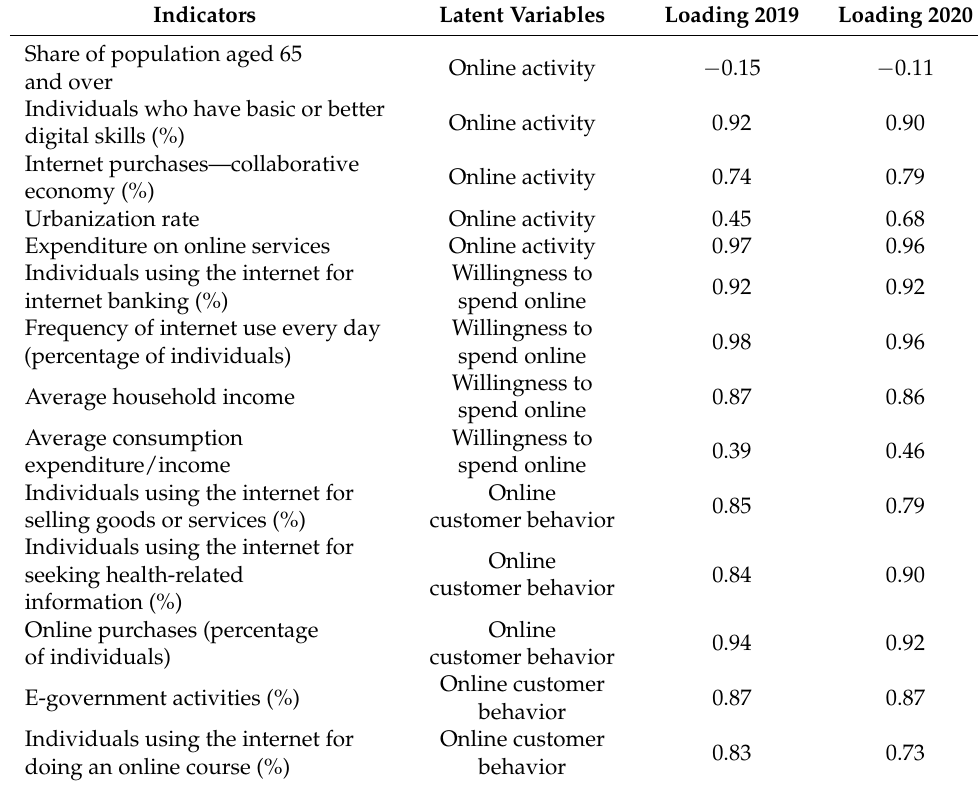
Table 1. Load factor values for individual